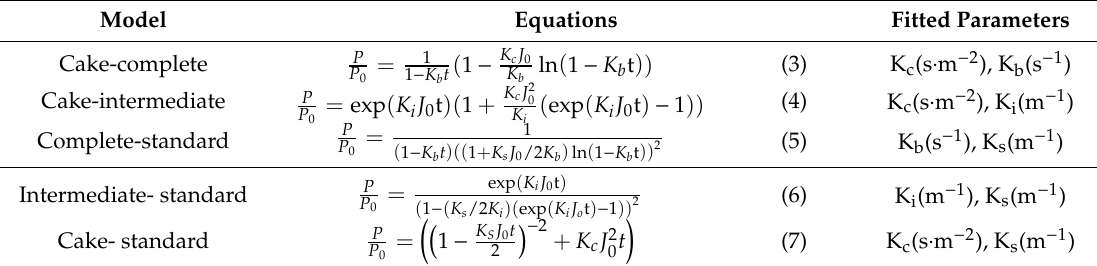
Table 2. Combination of five models under constant flow.